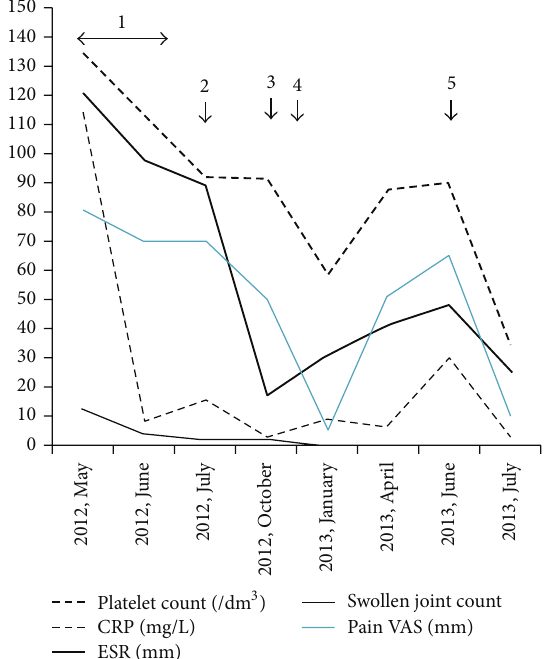
Figure 1: Clinical and biological parameter evolution under treat- ments. (1) Methylprednisolone 120mg : 3 infusions, (2) methotrex- ate 10 then 15mg a week (4 months) + prednisone 10mg, (3) hydroxyurea500 mgdaily+degressiveprednisone40 mg → 5mg(1 month), (4) corticosteroid stop, and (5) hydroxyurea 1500 mg daily, no